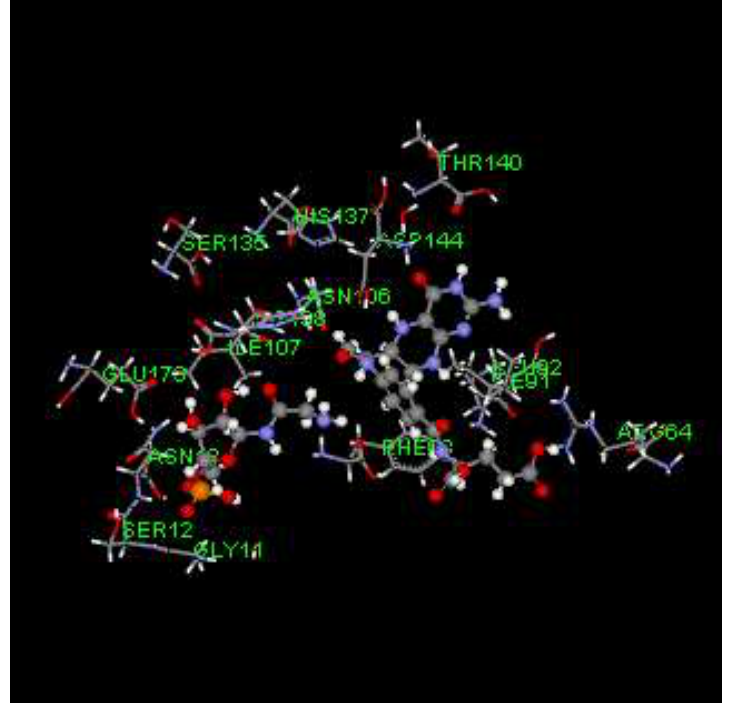
Fig. 2 The QM/MM calculation model